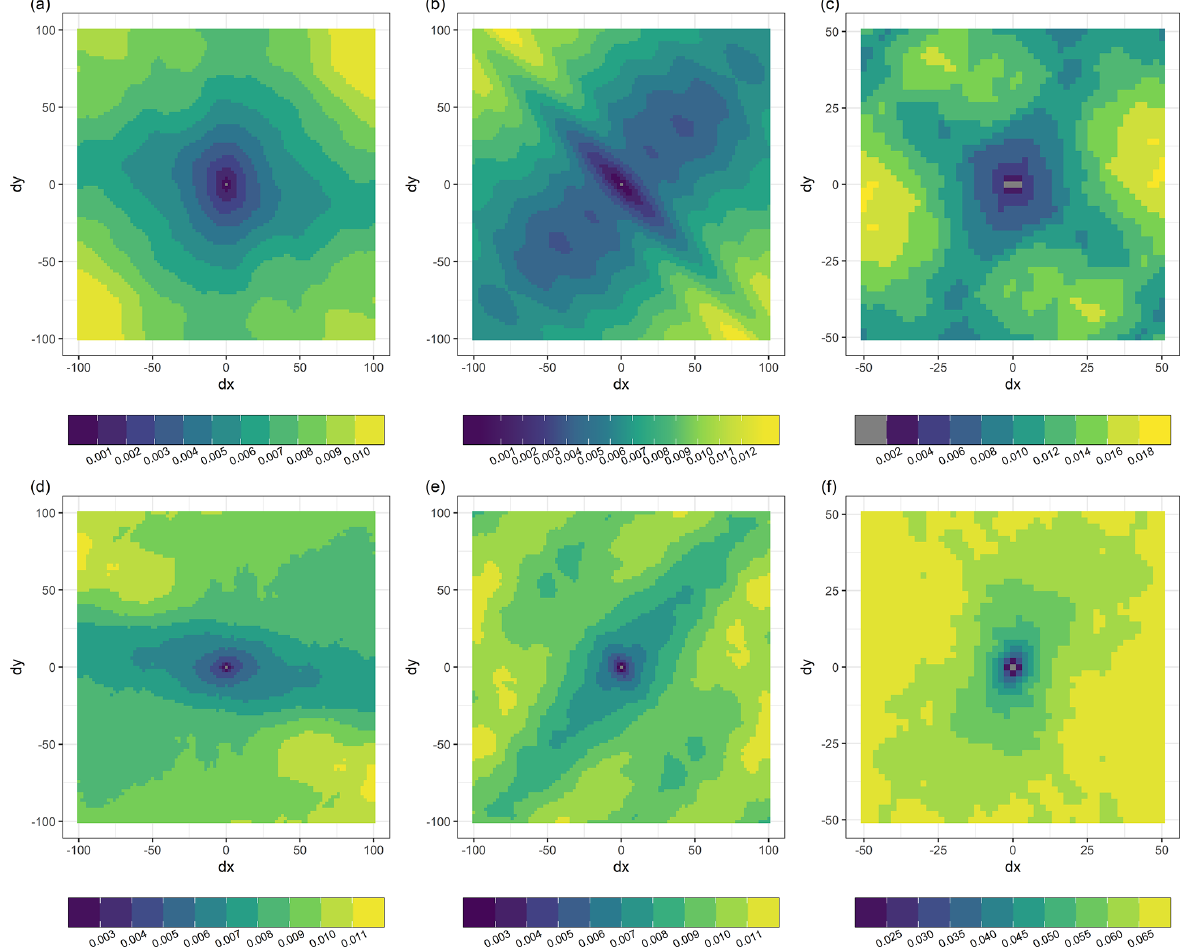
Figure 6. Directional semi-variogram of snow depth in (a) Sainte-Marthe field, (b) Saint-Maurice field, (c) Montmorency field, (d) Sainte- Marthe forest, (e) Saint-Maurice forest, and (f) Montmorency forest.